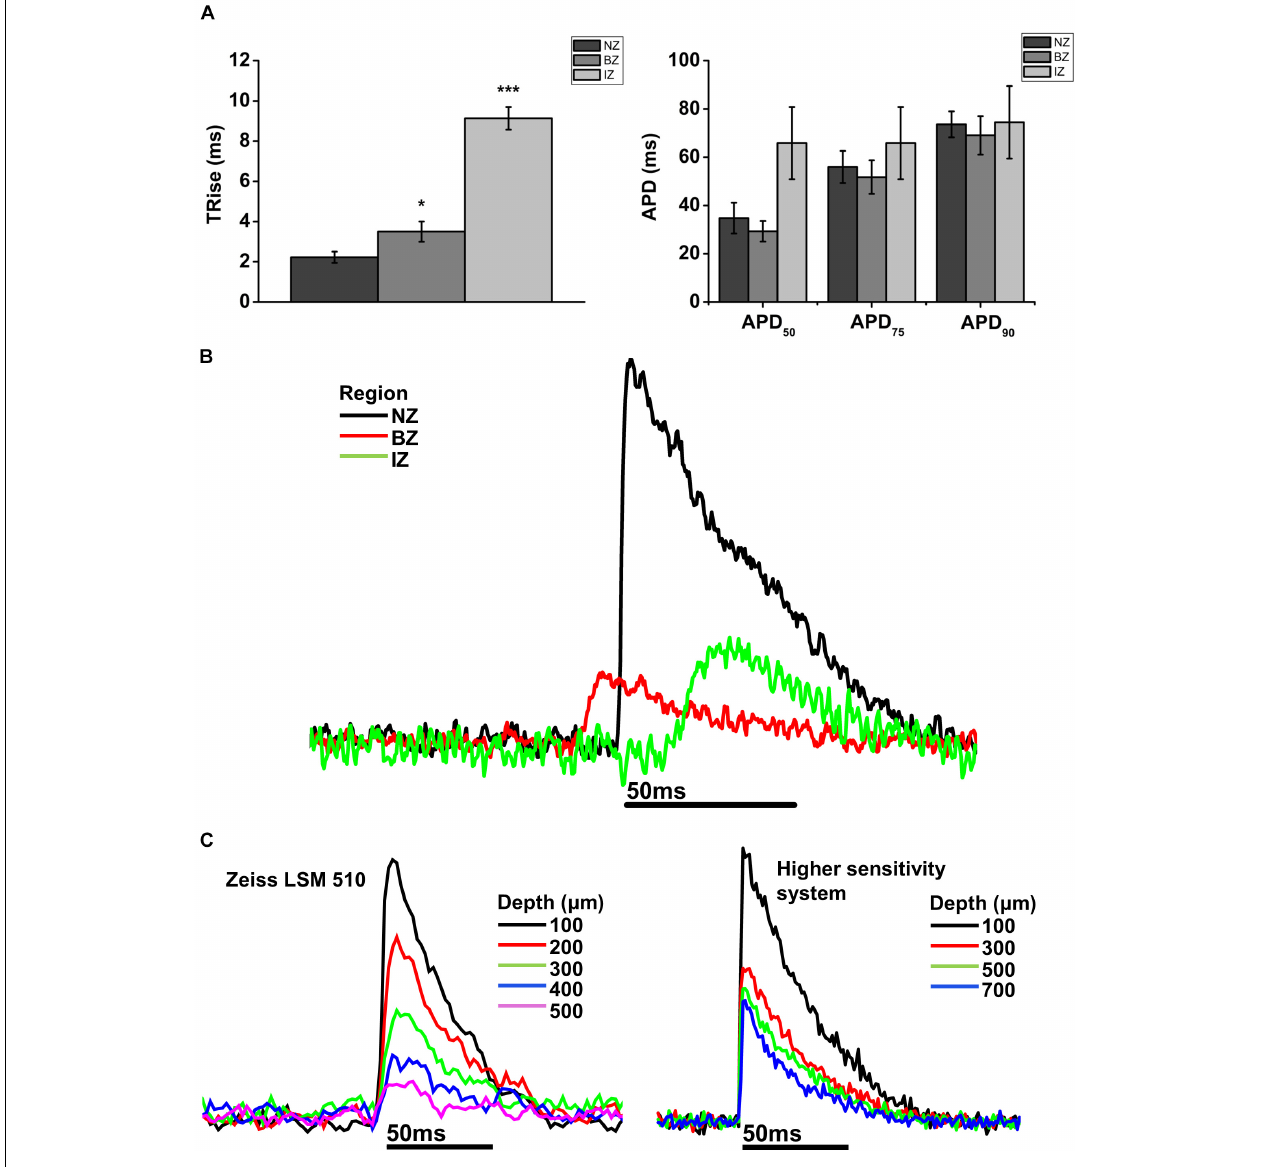
FIGURE 5 | Comparison of AP parameters in normal zone (NZ), border zone (BZ), and infarct zone (IZ). (A) Mean 10–90% upstroke rise time (TRise) and mean action potential duration (APD) at 50, 75, and 90% repolarization obtained from 2P signals for each heart in each region. NZ, n = 6; BZ, n = 4, IZ, n = 3. ∗ p < 0.05; ∗∗∗ p < 0.001. (B) Representative traces from a rat MI heart showing action potentials recorded using 2PLSM from three imaging zones: Normal zone (NZ), borderzone (BZ), and infarct zone (IZ). AP upstroke was slowed in both BZ and IZ compared to NZ, with no obvious difference in APD. (C) Transmural action potentials recorded using two microscope systems: Zeiss LSM 510 (left) and a microscope system featuring optimized detection and optical configuration (right). Note there was no change in AP morphology with either imaging system over the depth range investigated.